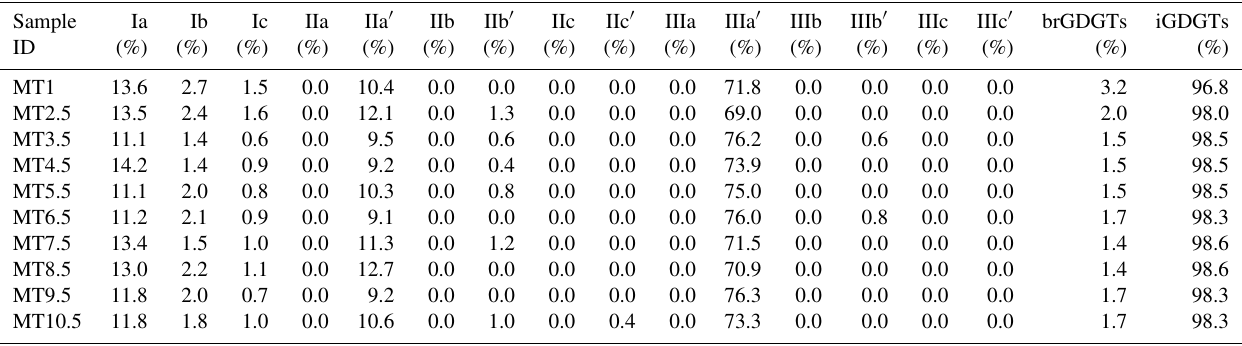
Table 2. Fractional abundance of brGDGTs and iGDGTs in the Mariana Trench sediments. Sample